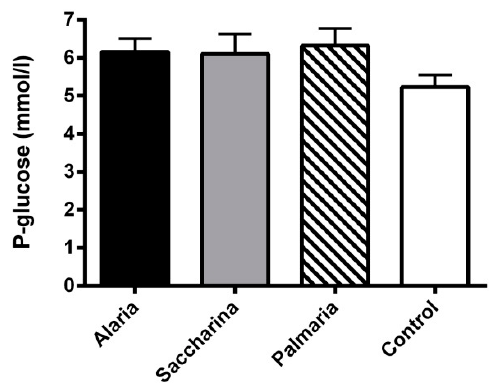
Figure 1. Fasting plasma glucose from the KK-Ay mice at the end of the 11-week intervention with diets supplemented with Alaria esculenta , Saccharina latissima , or Palmaria palmata compared to chow (control). No significant differences were found between groups. Values are means ± SEM.